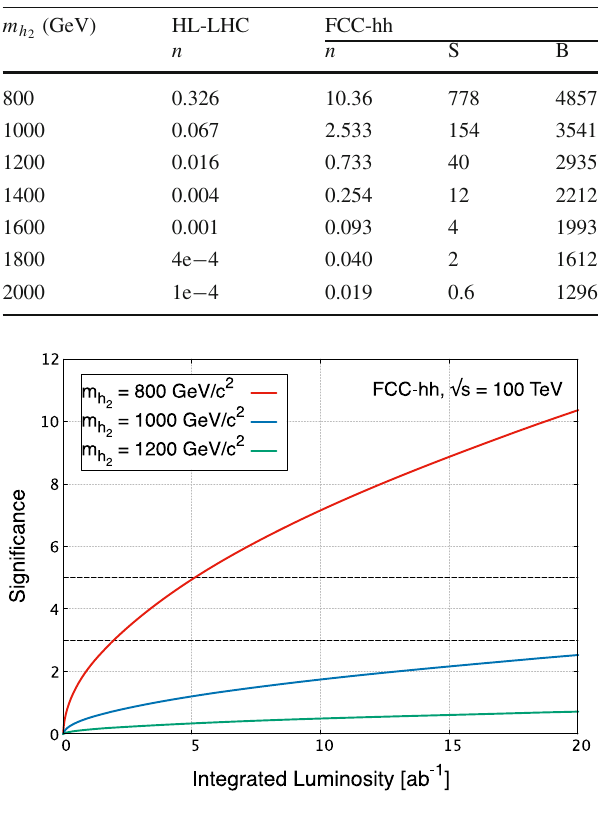
Fig. 14 Signal significance as a function of integrated luminosity at = 800, 1000 and 1200 GeV. The dashed 100 TeV FCC-hh for m h 2 lines correspond 3 σ and 5 σ